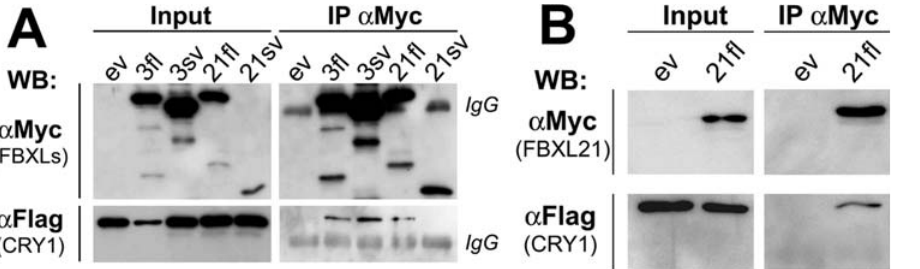
Figure 2. Ovine and murine Fbxl3 and Fbxl21 physically associate with oCry1. A . Extracts from COS7 cells co-transfected with Myc-Fbxl and Flag-Cry1 expression vectors were submitted to immunoprecipitation (IP) with a -Myc beads followed by western-blotting (WB). The oCRY1 protein was readily co-purified with oFbxl3fl, oFbxl3sv and oFbxl21fl but not with oFbxl21sv. Note the low CRY1 levels in the input when Fbxl3fl was present. Similar detection levels of IgG (from Myc antibodies) across all conditions demonstrate loading of comparable amounts of supernatant. ev=empty expression vector. B . The use of similar methods demonstrates that the mouse Fbxl21 also interacts with oCRY1.